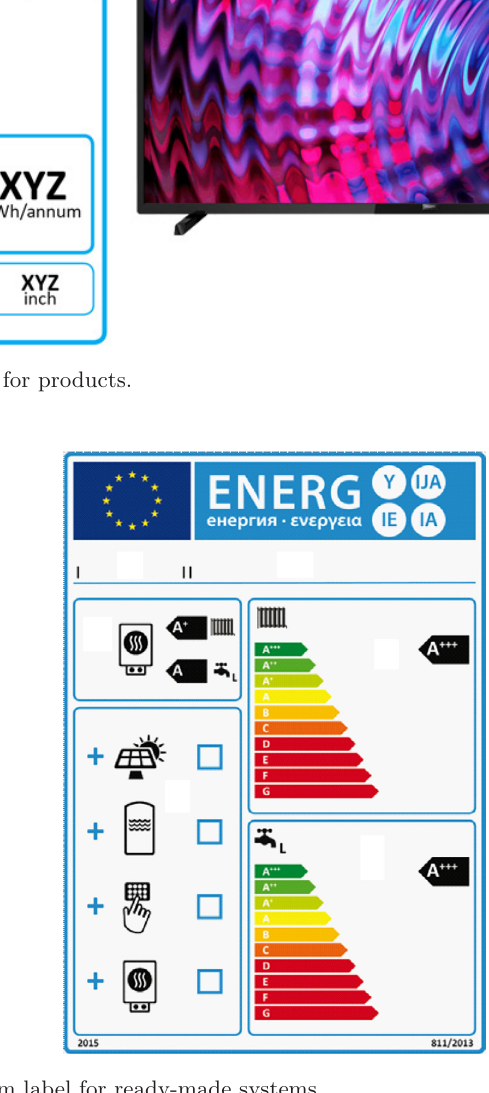
Fig. 16. – ErP-system label for ready-made